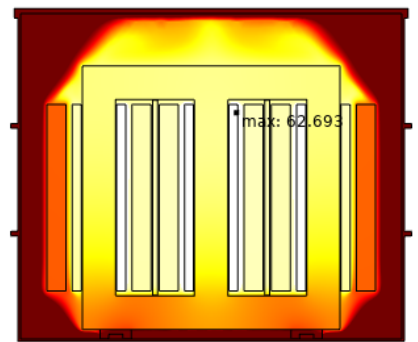
Figure 17. Temperature distribution (hot points) inside the tank for SF6 gas insulated transformer.